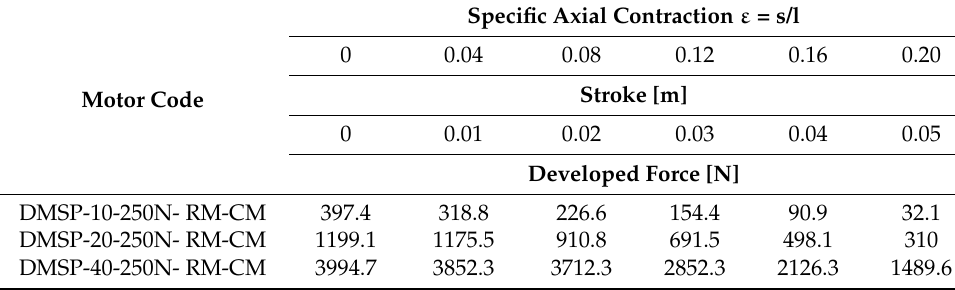
Table 5. Forces developed by the DMSP pneumatic